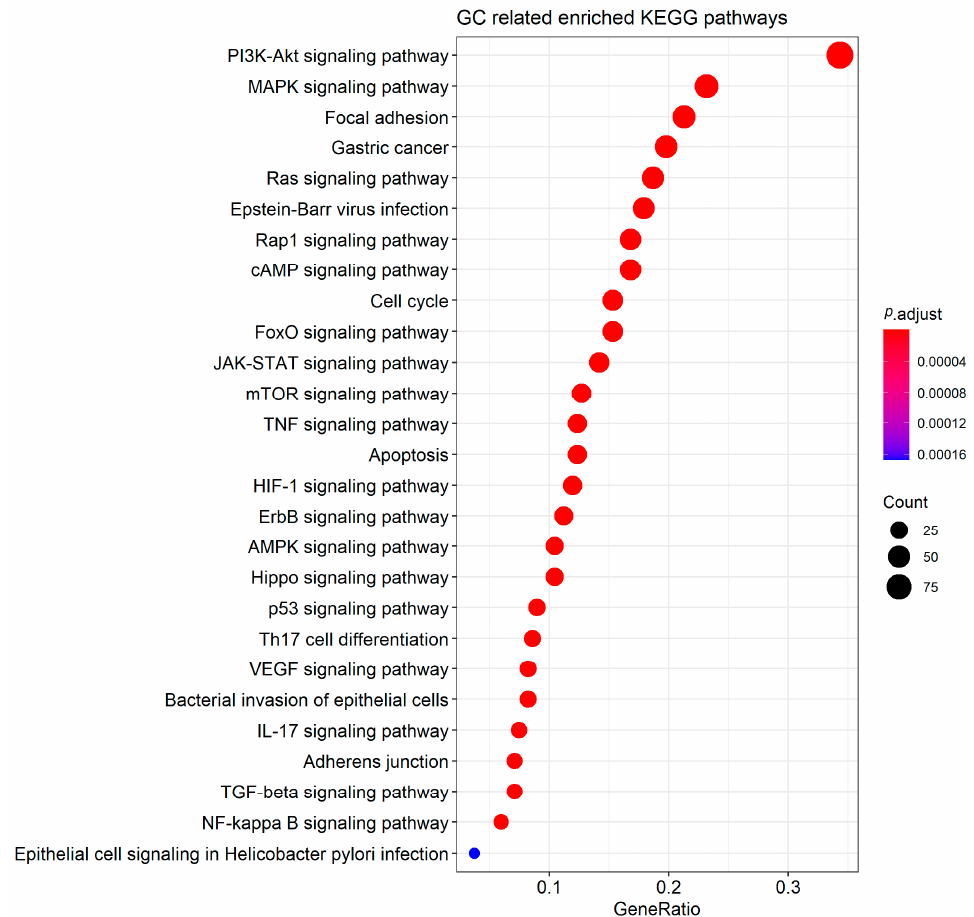
Figure 2. Gastric cancer (GC)-related Kyoto Encyclopedia of Genes and Genomes (KEGG) pathways in which the sponged miRNAs’ target genes are potentially involved.